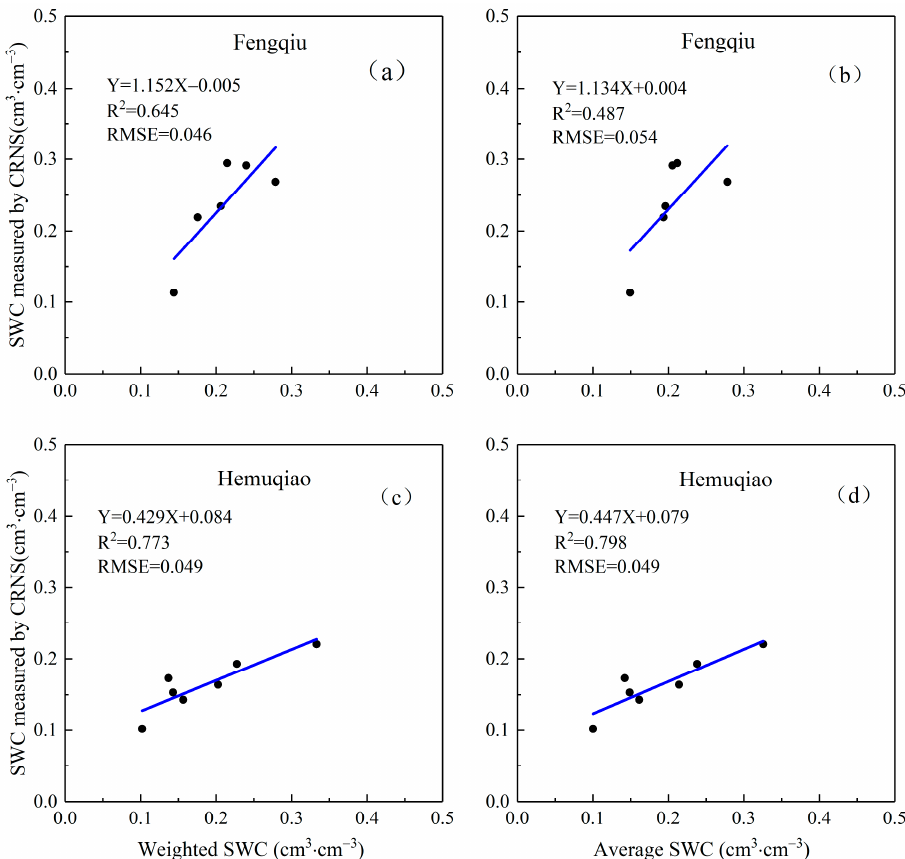
Figure 4. The SWC correlation between CRNS and point sampling. ( a ) The SWC correlation between CRNS and weighted point sampling in Fengqiu. ( b ) The SWC correlation between CRNS and averaged point sampling in Fengqiu. ( c ) The SWC correlation between CRNS and weighted point sampling in Hemuqiao. ( d ) The SWC correlation between CRNS and averaged point sampling in Hemuqiao.